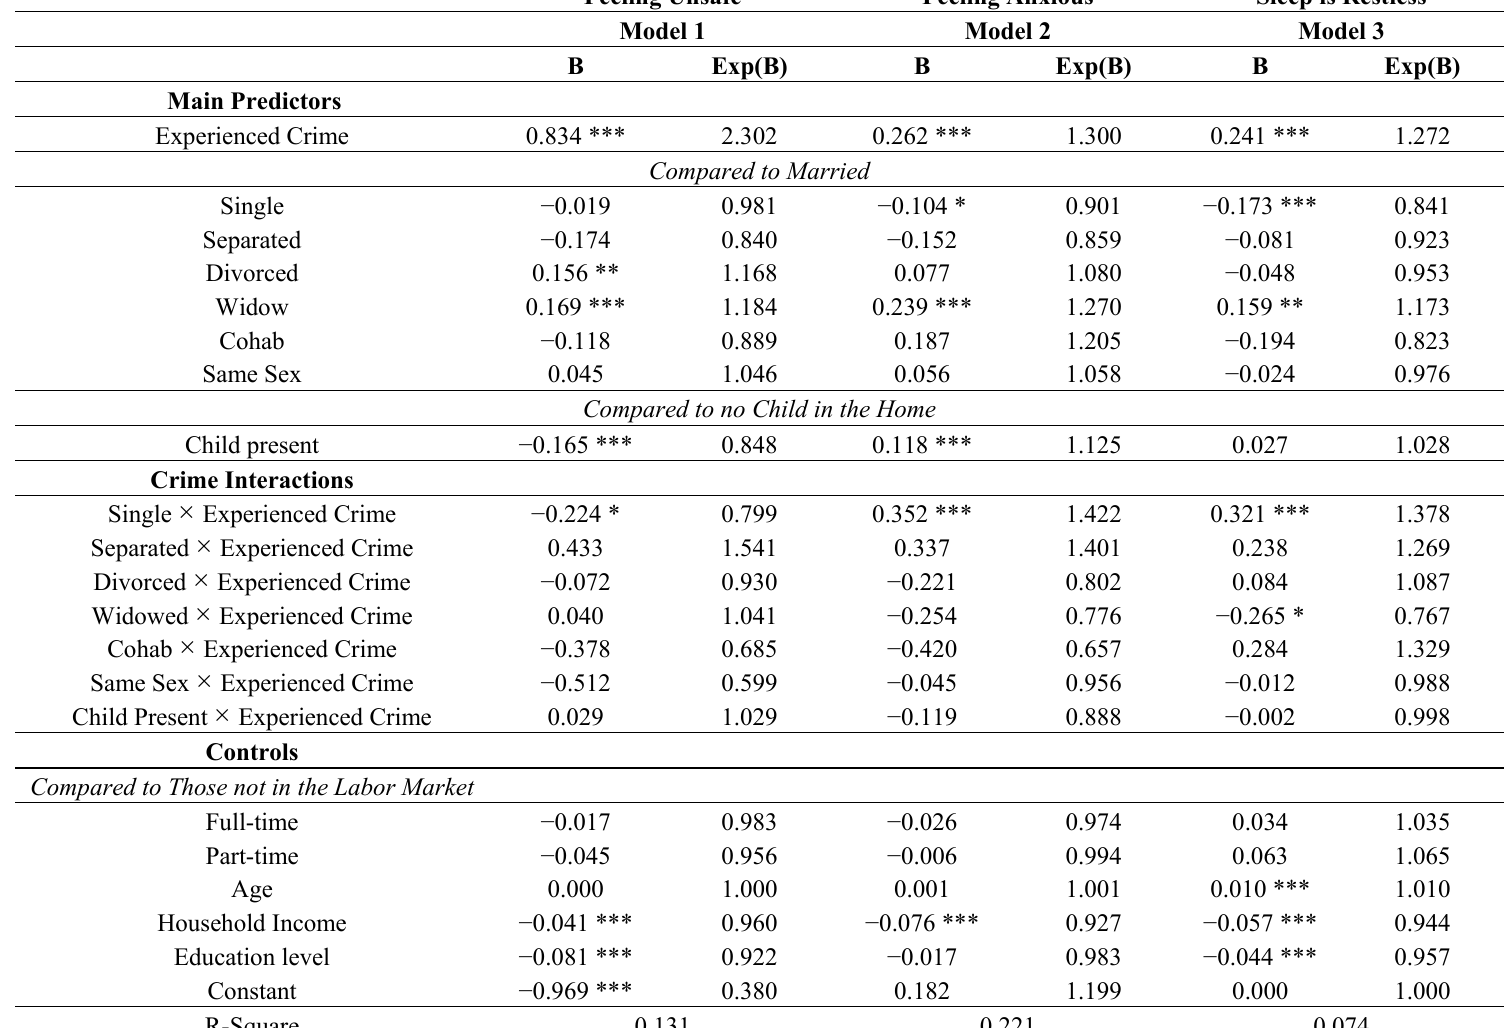
Table 3. Binary logistic regression coefficients for feeling unsafe, anxious and reporting restless sleep (ESS n = 28,768) [10]. Feeling